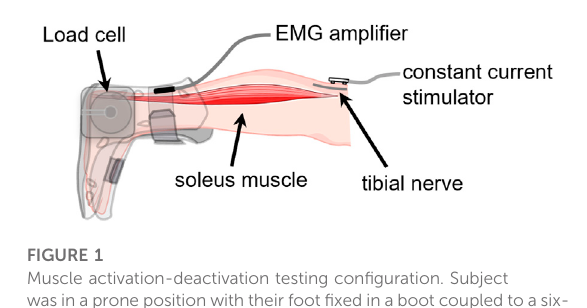
Muscle activation-deactivation testing con fi guration. Subject was in a prone position with their foot fi xed in a boot coupled to a six- degrees-of-freedom load cell. The subject was relaxed while a series of electrical pulses were delivered to the tibial nerve at the popliteal fossa. Created partially with BioRender.com.